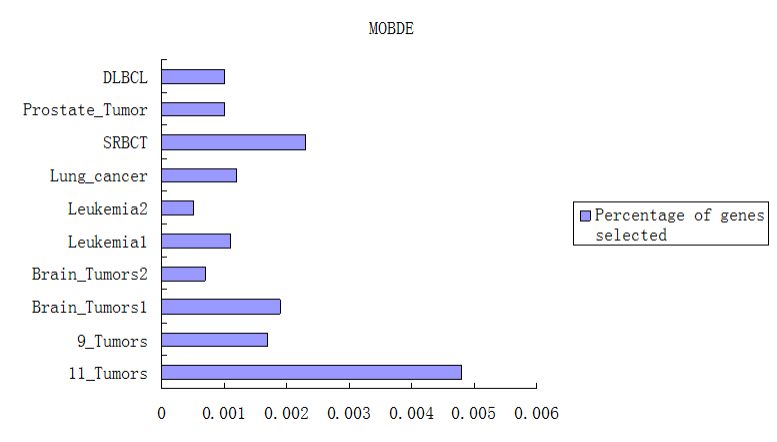
Figure 4. The percentage of genes